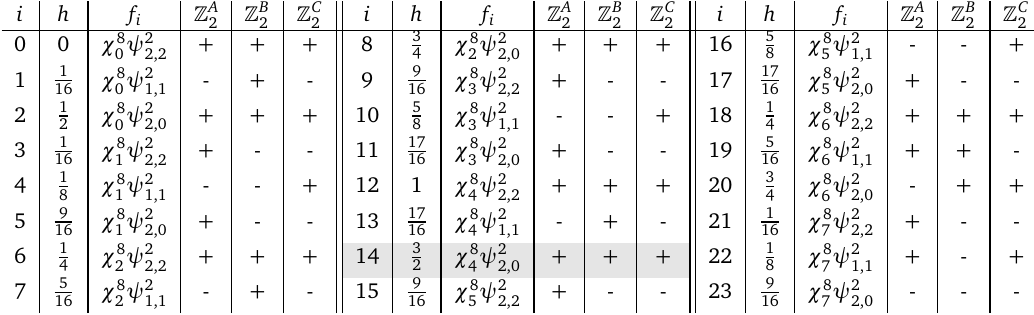
× Ising model: The conformal characters f Table 27: U ( 1 ) 8 can be expressed in terms of the characters of the U ( 1 ) χ l = 8 and ψ k = 2 . We highlight the primaries related to the discrete (cid:90) C (cid:96) , m